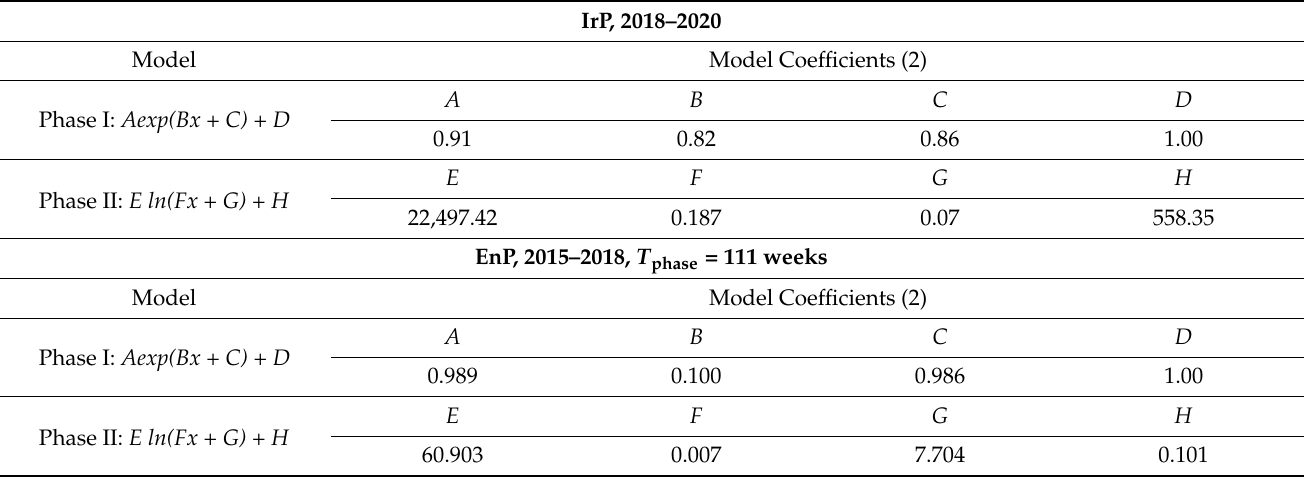
Figure 3. The dynamics of the area disturbed by silk moth for EnP в 2015–2018 гг. ( a ) and IrP в 2018– 2020 гг. ( d ), ASTER GDEM [26] is shown as background. Model of the monthly distribution of the area disturbed by silk moth for EnP, which approximates the Terra/MODIS data with 14 days temporal resolution, where I corresponds to exponential growth (phase “I”) and II is the approximating of the final stage. For IrP ( b ), 1 is the experimental data, 2 is an approximation the maximum of the final area, 3 is the model solution for the phase of exponential area growth, and 4 is the model solution for the phase of decreasing rate of area growth (logarithmic approximation) and further saturation ( e ). Plot of the correlation field for experimental measurement data (based on satellite data) and model calculation (S Model ) results for EnP ( c ) and for IrP ( f ). Table 1. Coefficients of the equations for the model of disturbed zone growth.